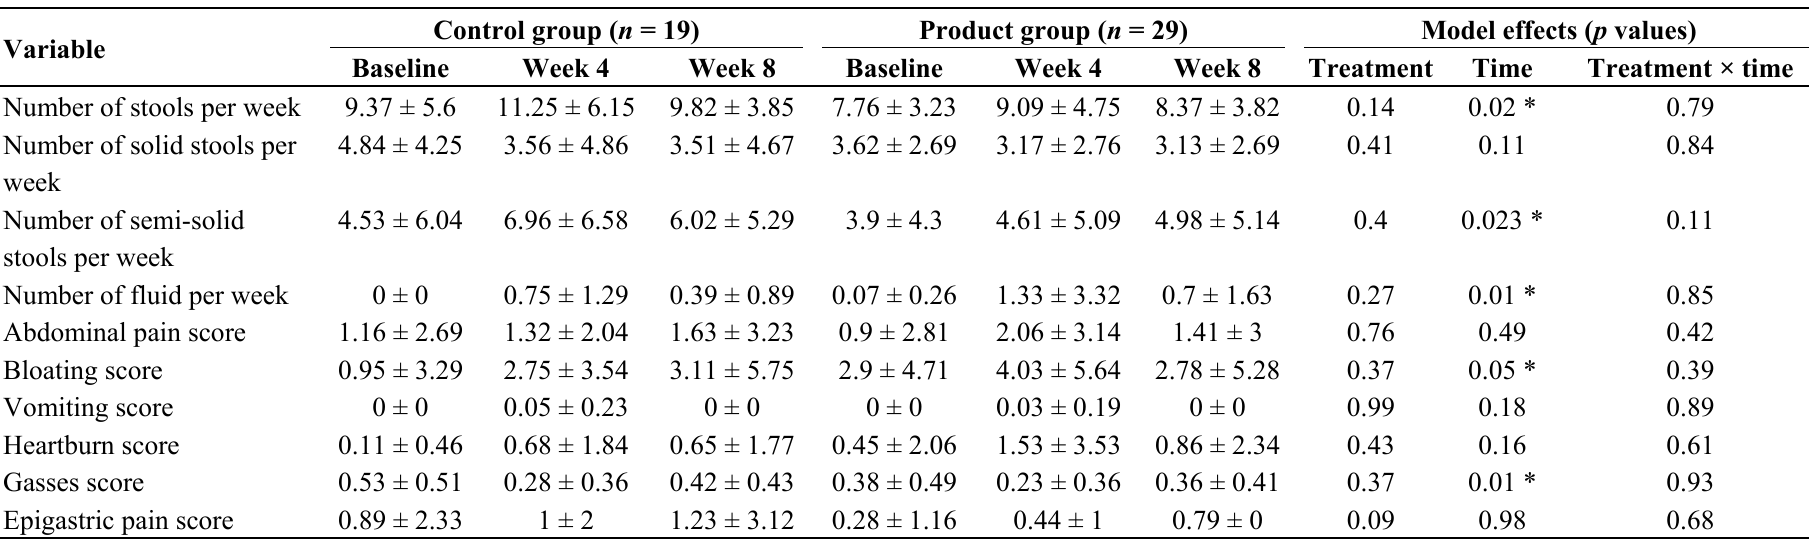
Table 3. Results of mixed model for relative changes in gastrointestinal symptoms during 8 weeks of juice drinking.